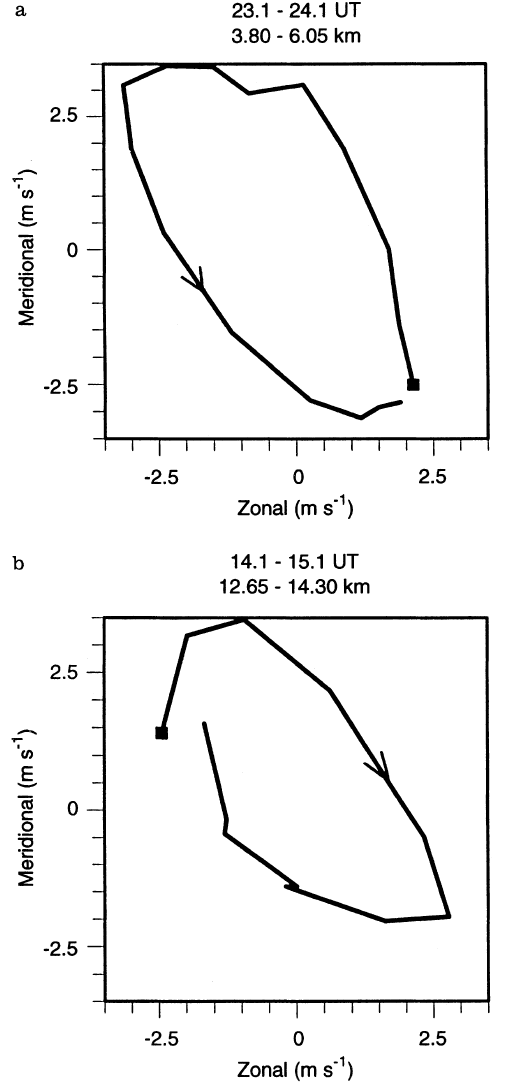
Fig. 4a, b. Hodographs of perturbation velocity for heights a below the tropopause, and b above the tropopause, based on mean values over 1.0 h and 150 m increasing height intervals, on 12 March 1994. The lowest heights are marked by solid squares and the directions of rotation with increasing heights are indicated by